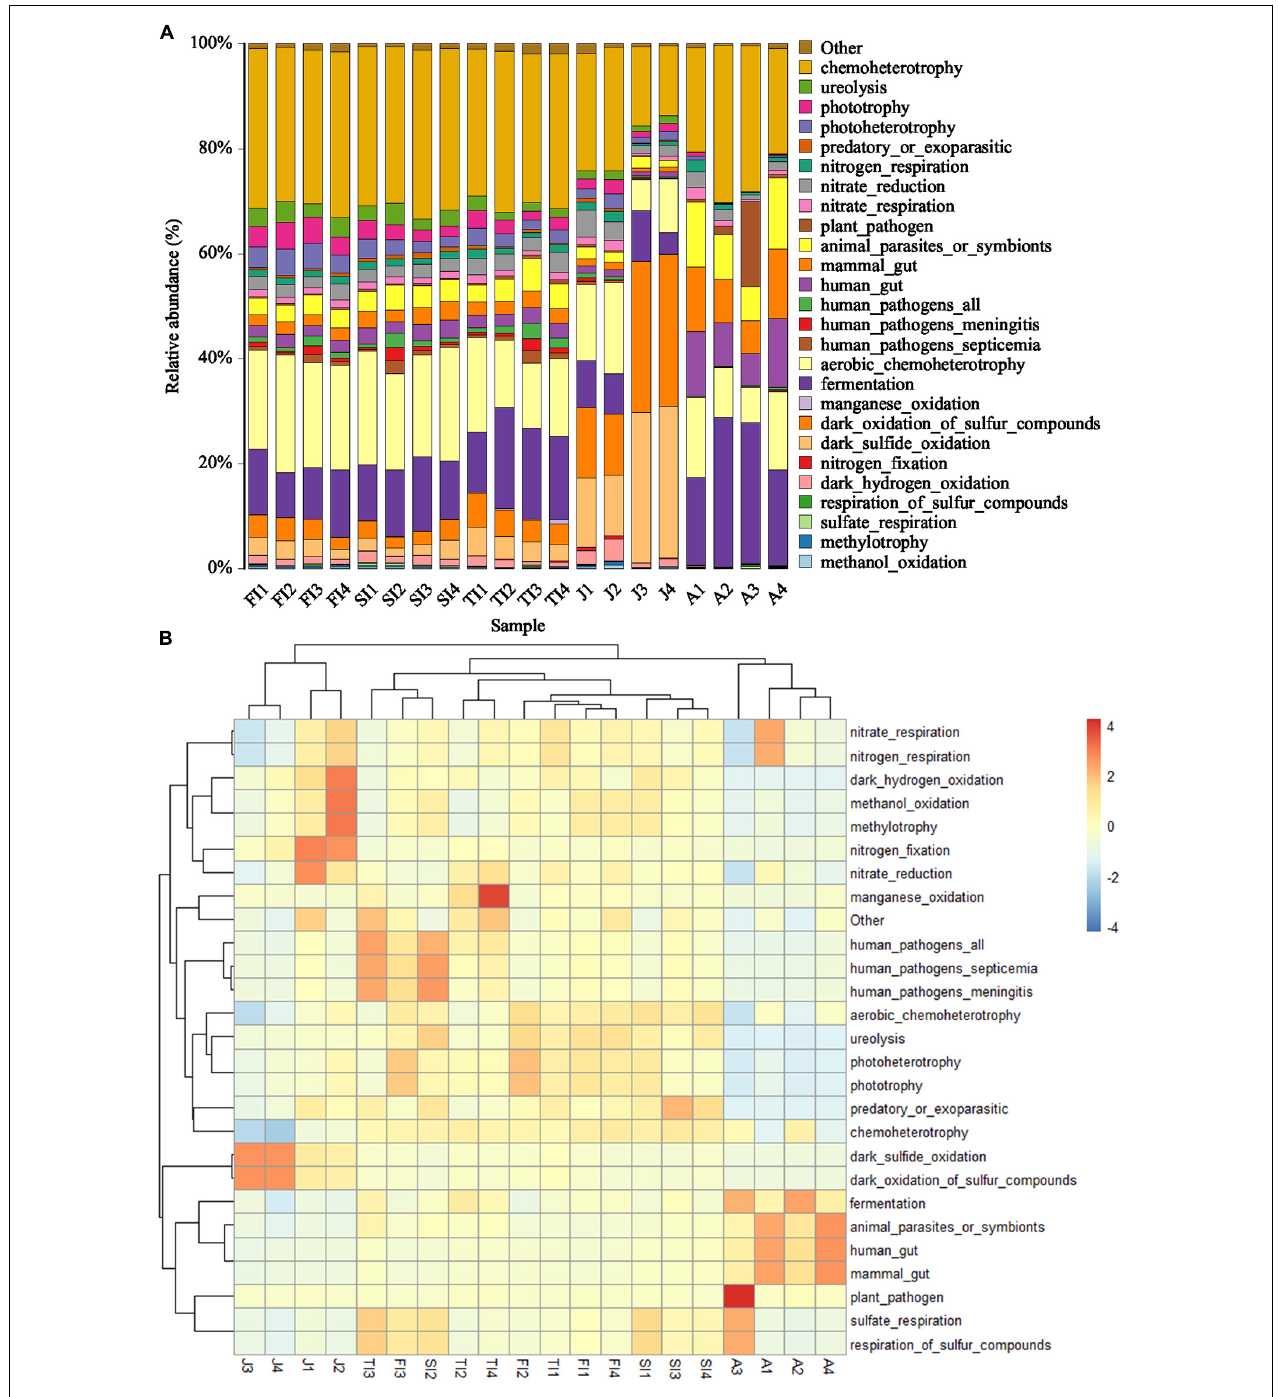
FIGURE 7 | Histogram (A) and Heatmap (B) showing the predicted function potentials of crayfish intestinal microbiota across development stages through FAPROTAX